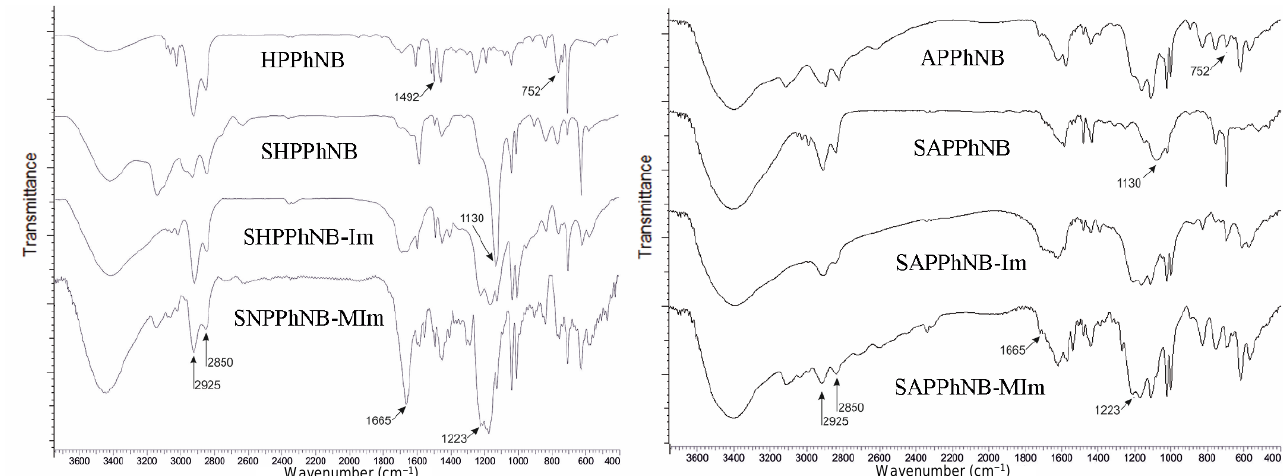
Figure 2. FT-IR spectra of the polymers.